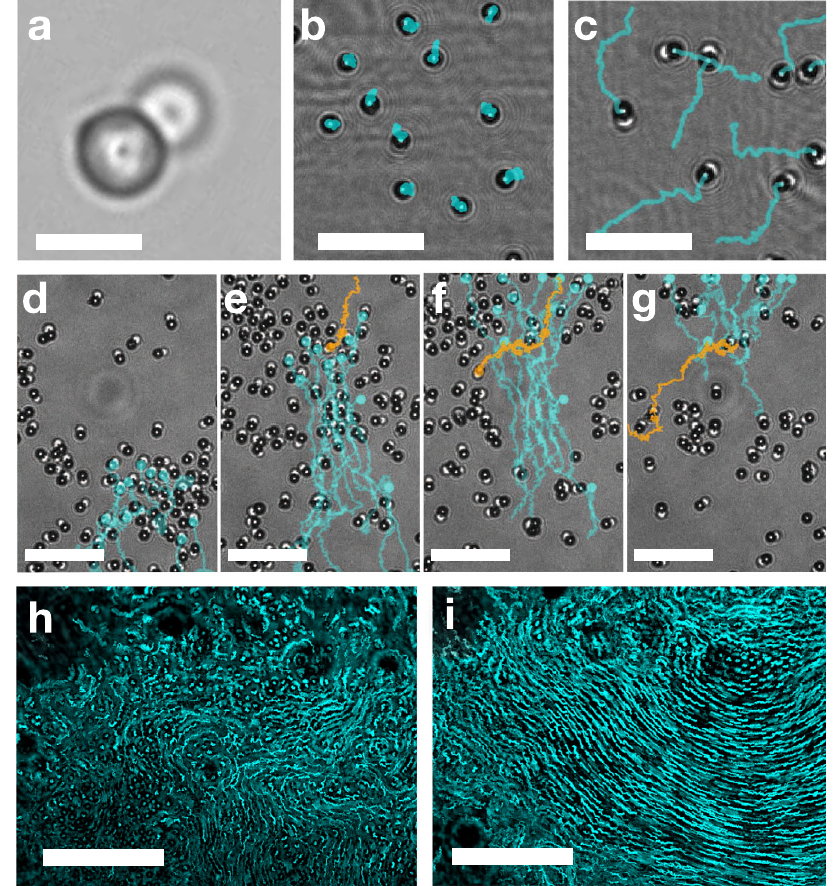
Fig. 1 The light-driven fuel-free micro-swimmers display distinct behaviours at different densities. a a single micro-swimmer is composed of a light- absorbing particle (dark sphere), and a fl uid droplet (white sphere). 8 second long trajectories of individual swimmers show the transition from diffusive dynamics when light is off ( b ) to ballistic when light is turned on ( c ) (see Supplementary Video 3). d at an intermediate concentration, swimmers collide, align, and create small co-moving groups. d – g an individual swimmer (orange) maintains its activity even when passing through an oppositely moving group (cyan), penetrating, and emerging from the other side (see Supplementary Video 4). h , i long exposure (1 min) images of swimmers at high concentrations reveal internal fl ow structures (see Supplementary Video 5). Scale bars: a : 5 μ m; b , c : 20 μ m; d – g : 25 μ m; h, i : 50 μ